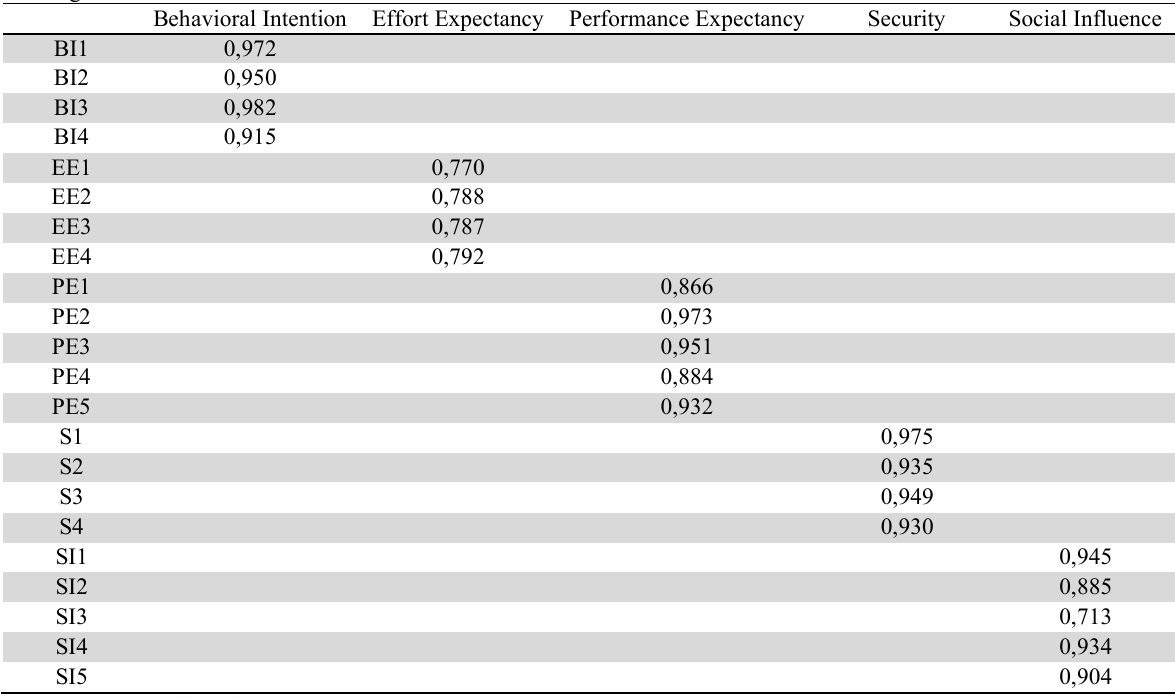
Loading factor Behavioral Intention Effort Expectancy Performance Expectancy Security Social